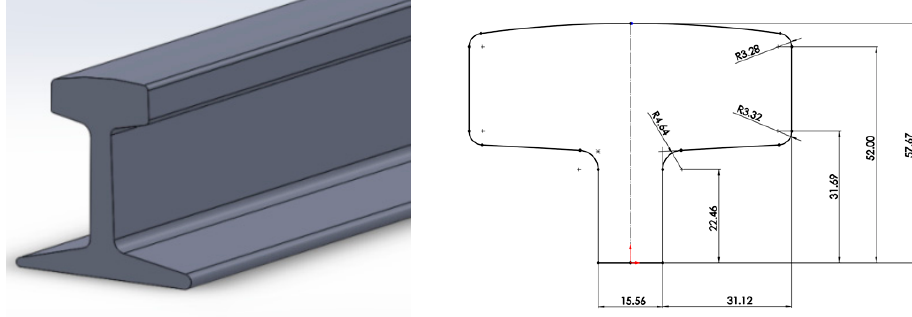
Figure 2. Complete railway and top cross section of rail in two equal segments. The bottom and top rolls used for the first three rolling passes are shown in Figure 3, Figure 4 shows details of their angles and dimensions, as well as the silhouette of the rolling. The diameter is 355 mm.